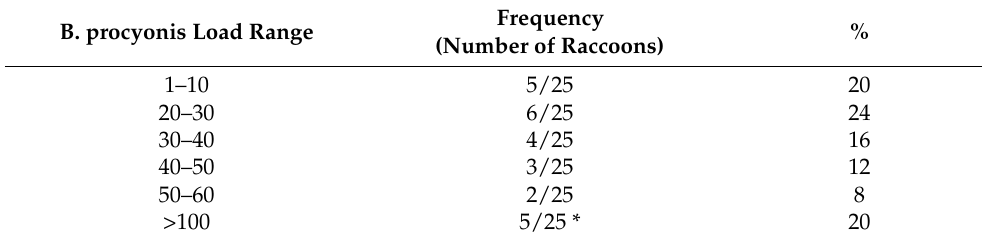
Table 3. Adult B. procyonis